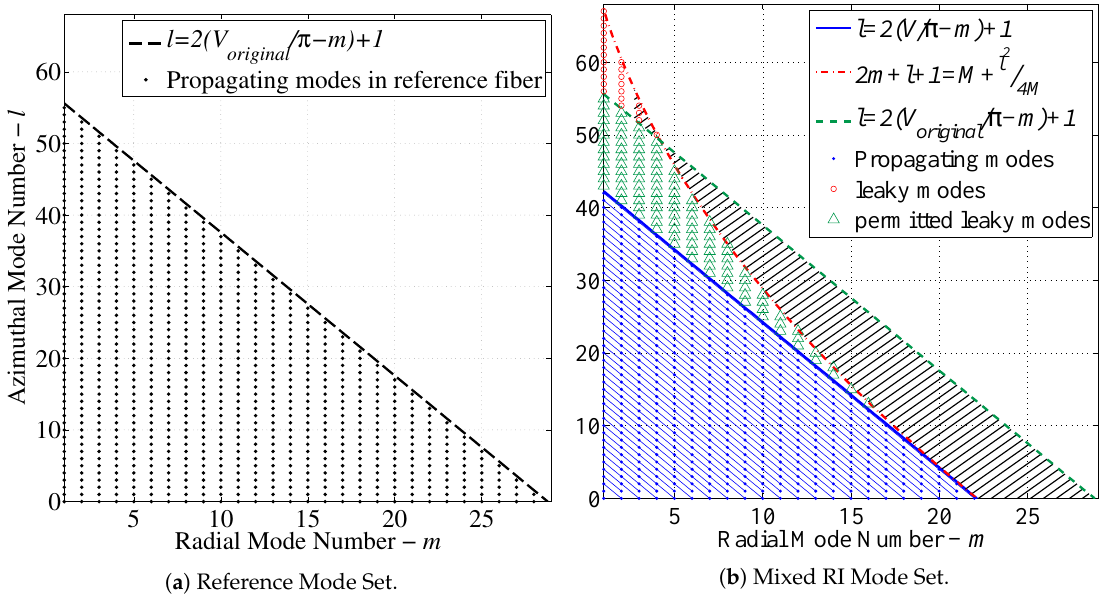
Figure 5. Permitted mode sets for ( a ) step index and diffusion modeled fibers and ( b ) mixed RI fibers